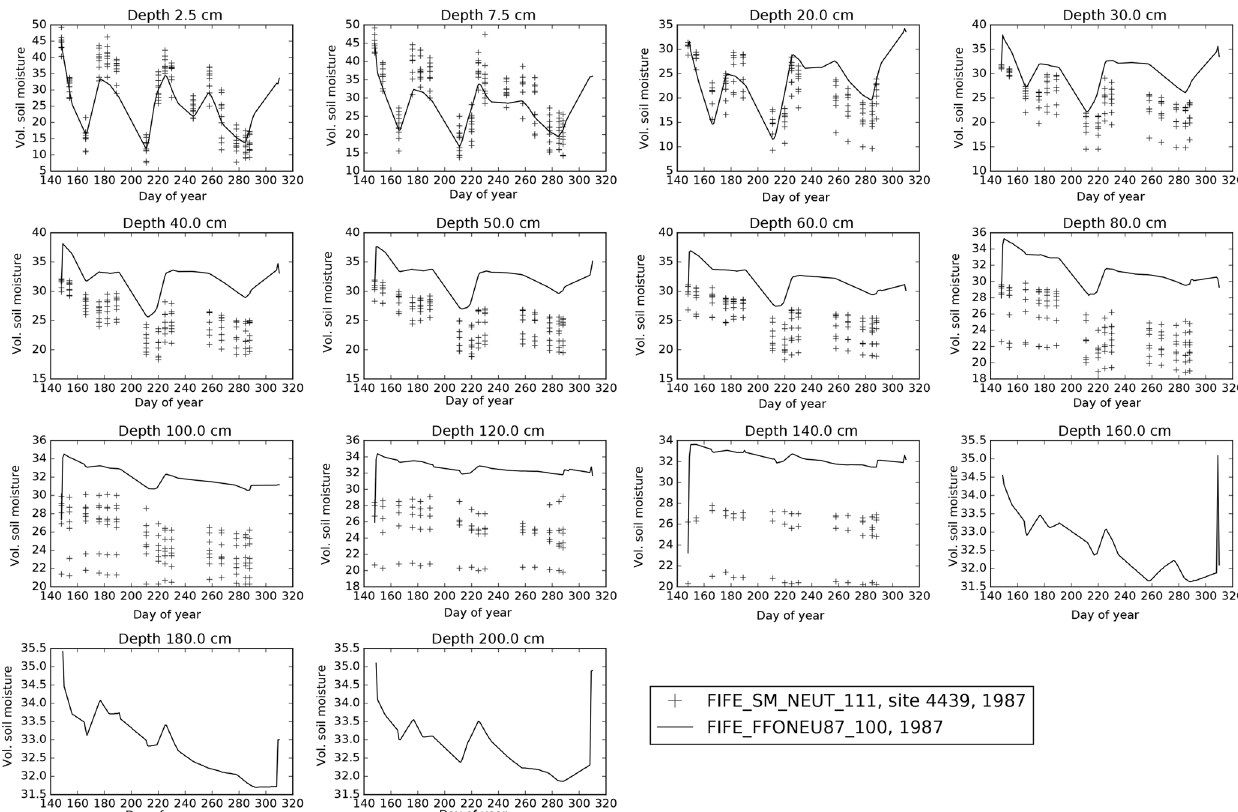
Figure A4. Site-averaged soil moisture on levels from FIFE_FFONEU87_100 for 1987 (line) and individual observations of site 4439 in 1987 from FIFE_SM_NEUT_111